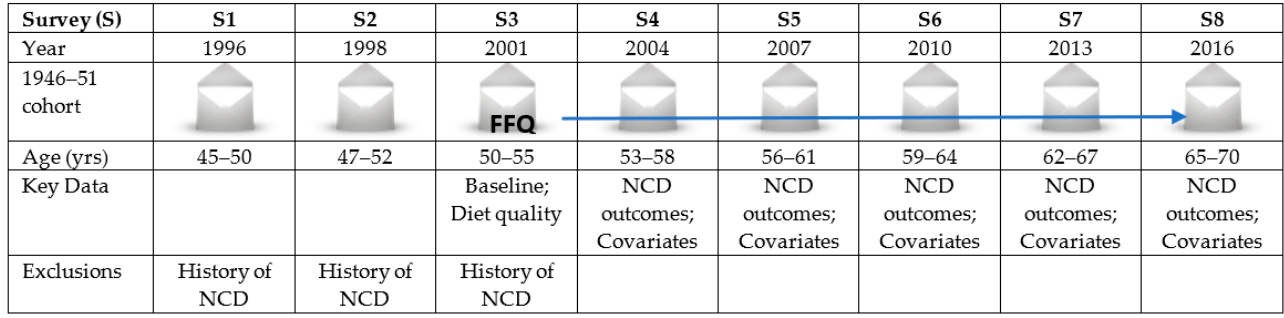
Figure 1. Study overview: data from the Australian Longitudinal Study on Women’s Health (ALSWH), born between 1946 and 1951.